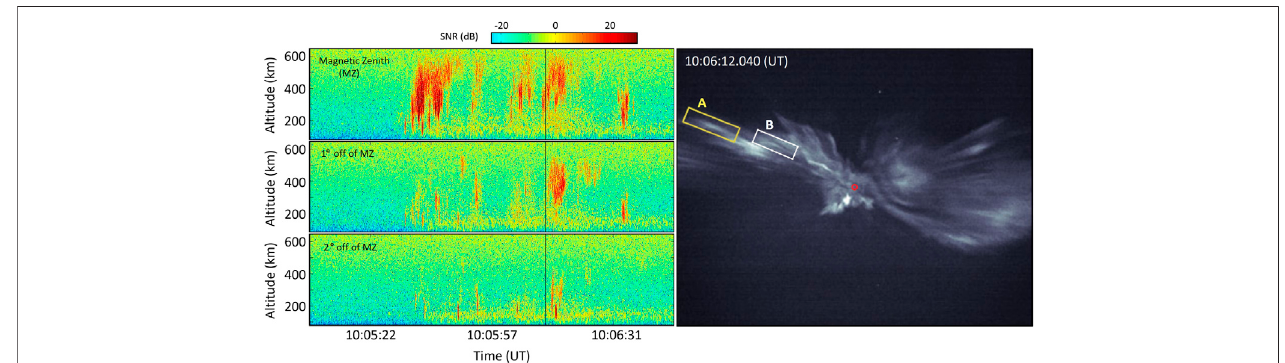
FIGURE 11 | Adapted from Dahlgren et al. (2013) and Akbari and Semeter (2014): Naturally Enhanced Ion Acoustic Lines and conjugate auroral features. The left panelsshowtheRange – Time – Intensityplotsofreceivedpowerintheionlinechannelforthreeradarbeamsduringaperiodwhenasubstormexpansioncrossedthrough the PFISR beam con fi guration. Mentioned in parentheses are angles with respect to the magnetic-zenith. The right panel shows an image captured by a high-speed, high-resolutionimagerat10:06:12.040UT,markedbytheverticallineintheleftpanels.Exampleopticalfeaturesidenti fi edas ‘ A ’ and ‘ B ’ show fl amingmotioninthe radial direction with respect to the red circle which marks the location of the magnetic zenith over Poker Flat, AK. A video of a sequence of optical images are available from Dahlgren et al.